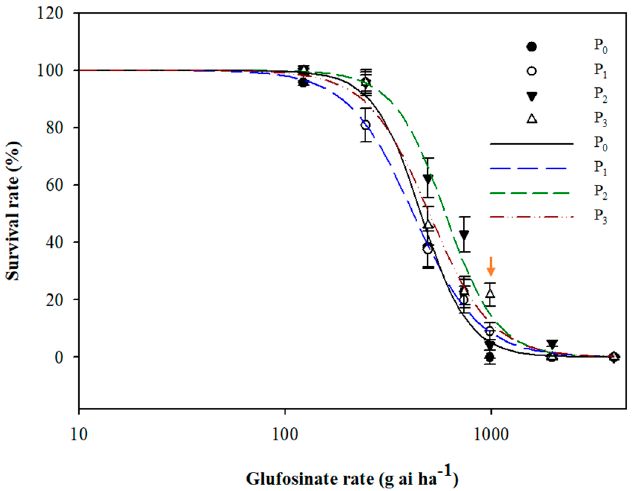
Figure 1. Dose–response of L. perenne ssp. multiflorum parental (P 0 ) and three successive generations (P 1 , P 2 , P 3 ) of progeny, selected with low glufosinate rates, to treatment with glufosinate in the greenhouse. Lines are the predicted values for percentage survival. Red arrow indicates the labelled field rate (984 g · ai · ha − 1 ). Table 2. Parameter estimates and associated model statistics for the log-logistic dose–response curves of plant survival following treatment with glufosinate at low doses. Population